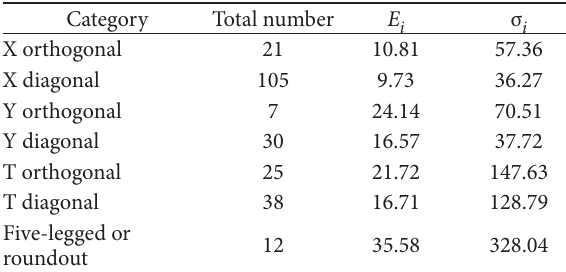
Table 2. Accidents statistics by intersection type